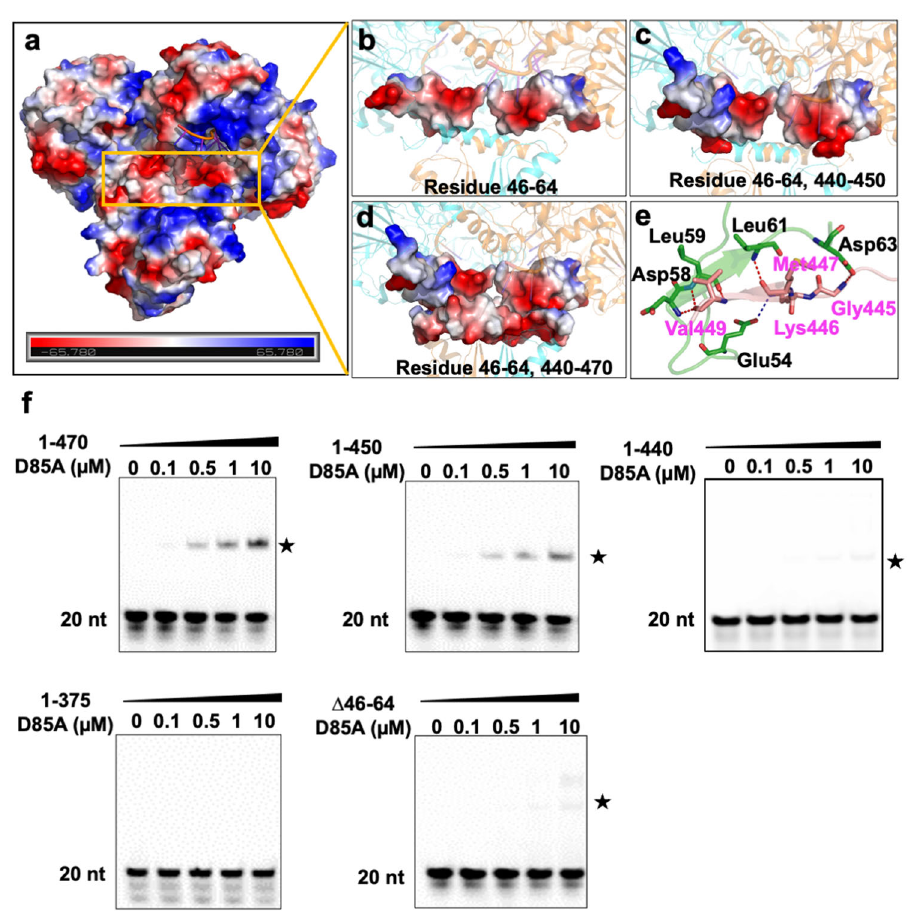
Fig. 6 | Negatively charged regions 46-64 and 440-450 of Mtb-RNase J were crucial for RNA binding. a The overallelectrostaticdistributionofthe Mtb-RNase J/ssRNA complex. The yellow box represented the substrate-entrance pocket. Red: negative potential; blue: positive potential. b The surface electrostatic potential of region46-64inMtb-RNaseJ. c Thesurfaceelectrostaticpotentialsofregions46 – 64